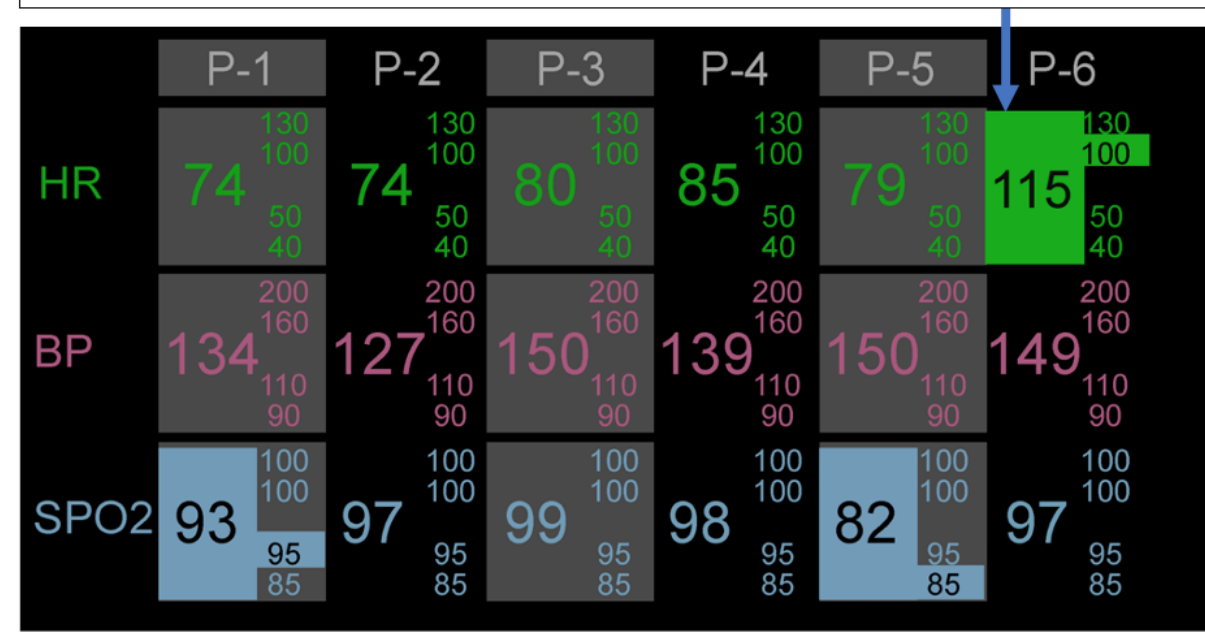
Figure 23. Continuous streams of patient data were presented on the head-mounted displays for up to 6 patients by Pascale et al [35]. The display was similar to the one from the study by Klueber et al [34], with the difference that this display also monitored blood pressure and abnormal values had their background highlighted. In this example, we can see that patients P-1, P-3, P-5, and P-6 have abnormal variables (a model of the concept presented in the paper). BP: blood pressure; P: patient; SpO 2 : oxygen